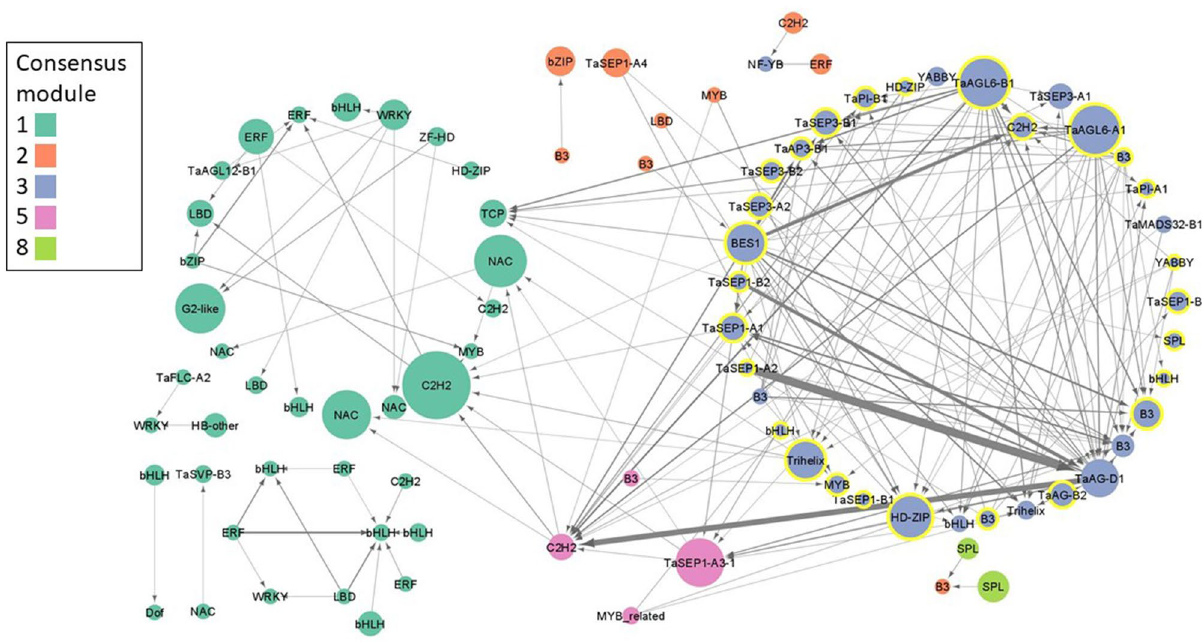
Figure 3. Causal structural inference prediction of interacting transcription factors, filtered for edge weight ≥ 0.03. Nodes (genes) are colored by their consensus network modules, and consensus100 module 9 genes are highlighted with a yellow border. Node diameter is scaled to betweenness centrality to indicate its importance within the network. Directional interactions are indicated by arrows and width is scaled to predicted interaction